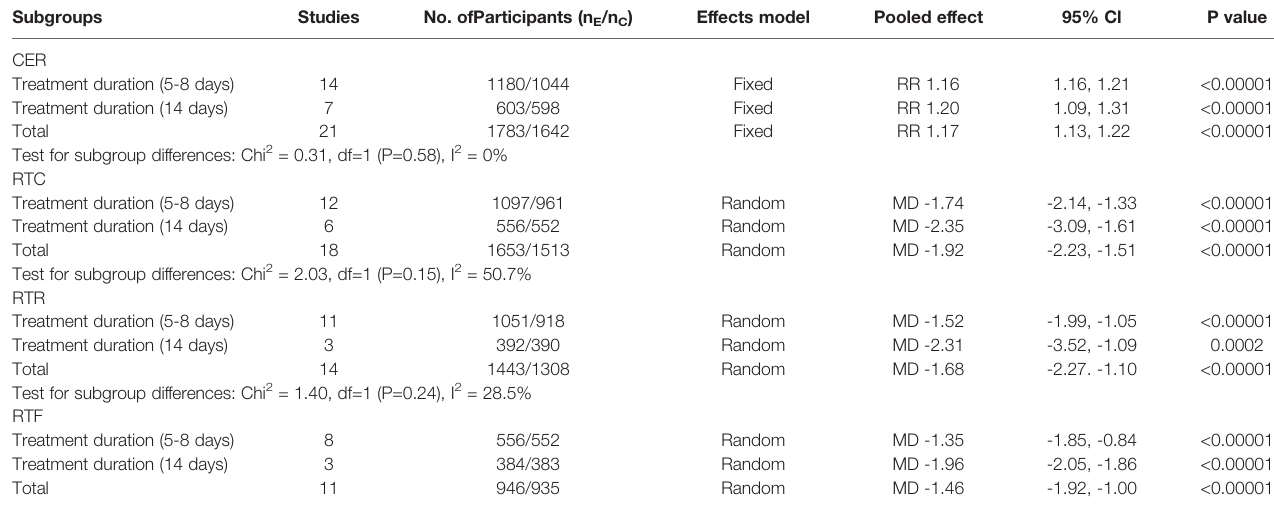
TABLE 2 | Subgroup analysis for treatment